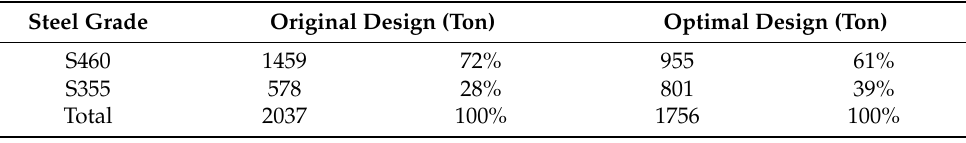
Table 3. Comparison of steel grade used.